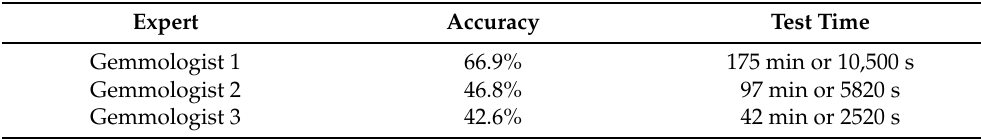
Table 3. Accuracy and test time of three expert gemmologists classifying the 284 unseen images varied